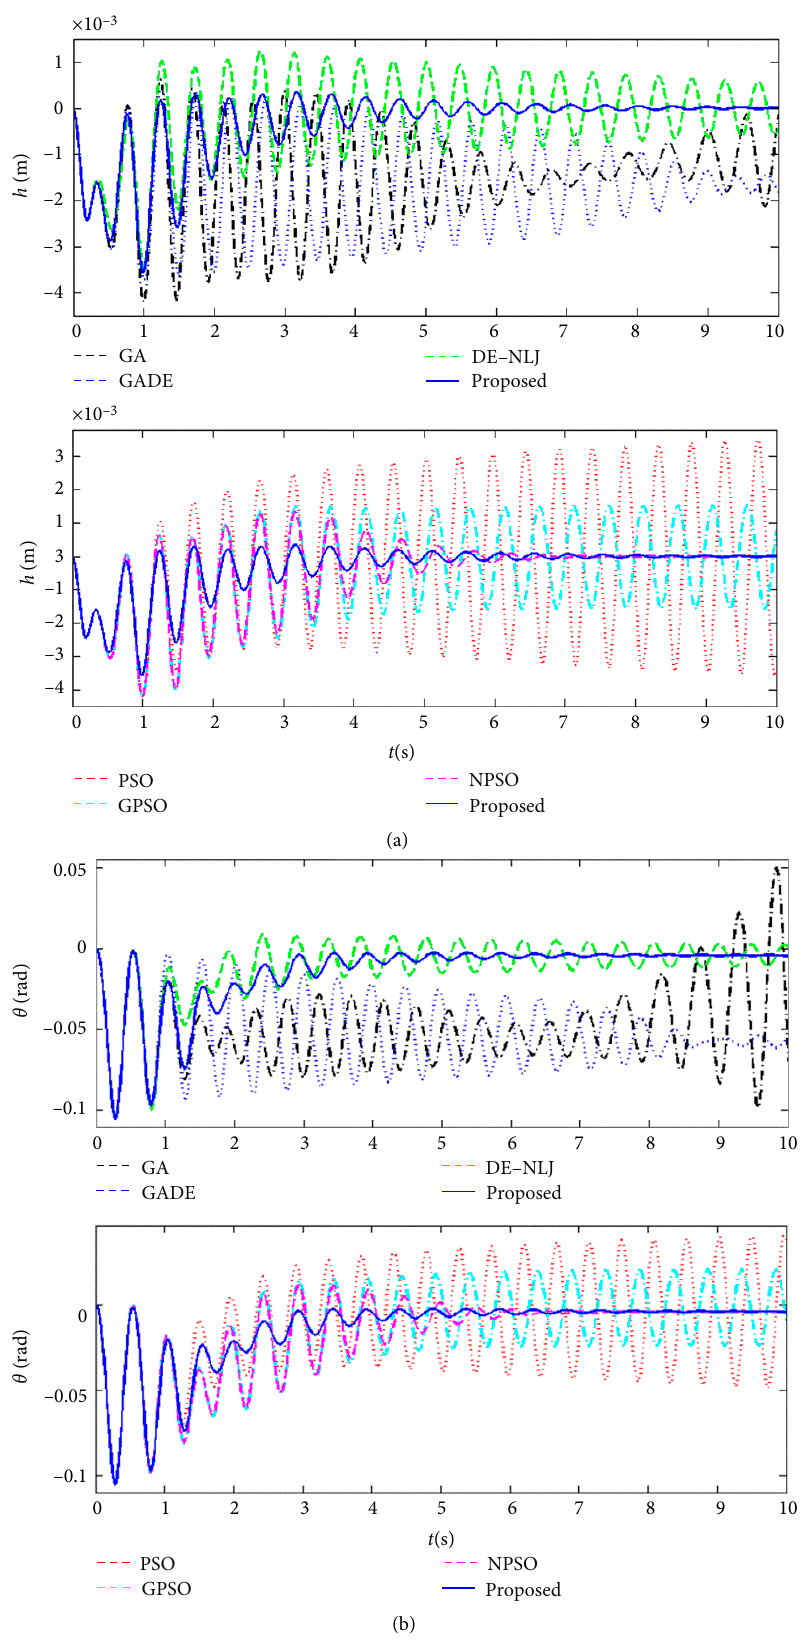
Figure 11: Comparison of (a) plunging response, (b) pitch response obtained by GA, PSO, NPSO, GPSO, DE–NLJ, GADE and GNPSO based IMC-PID control of MIMO nonlinear wing vibration